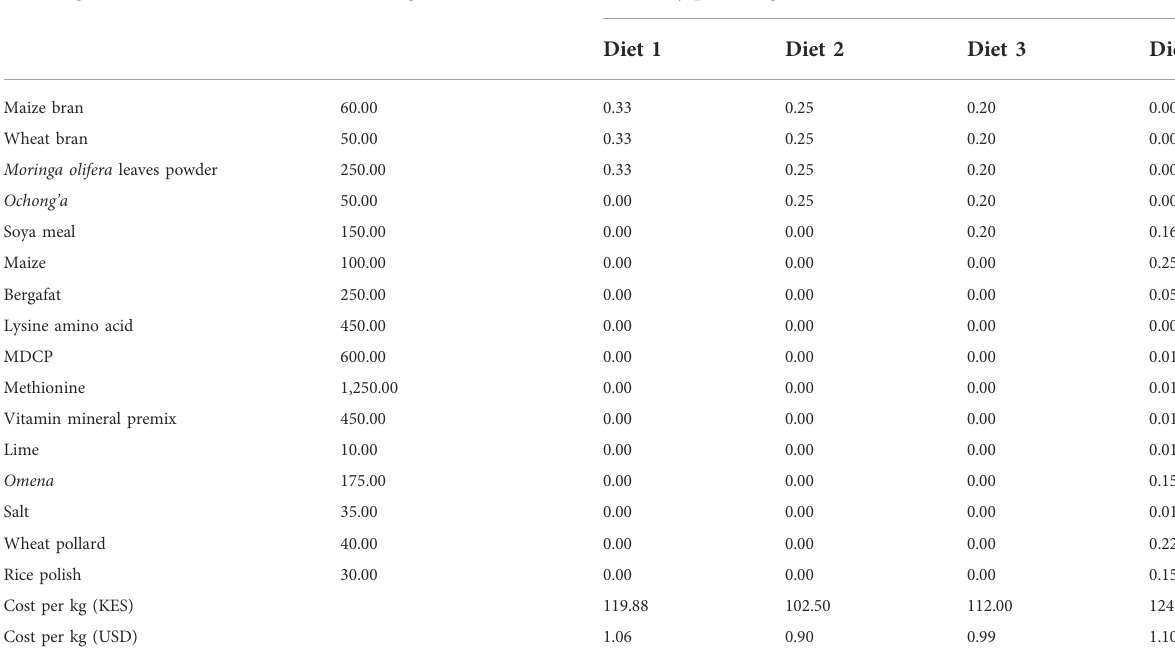
TABLE 3 Cost of diets used for rearing Ruspolia differens .